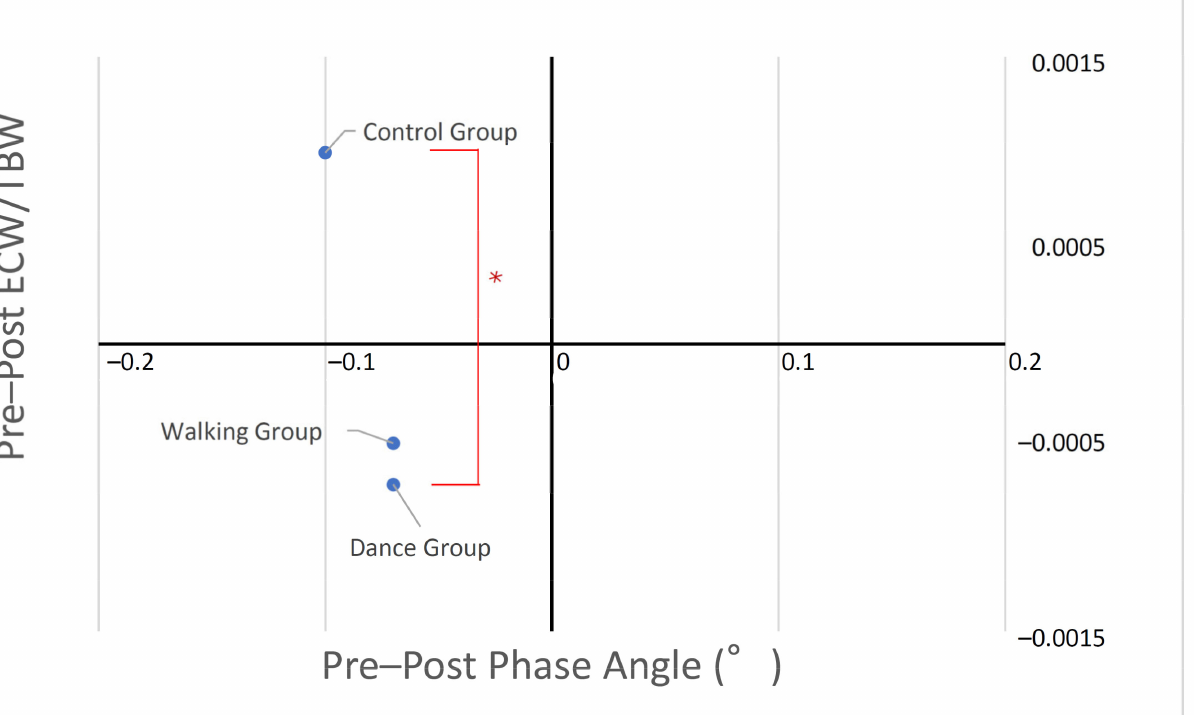
Figure 3. Comparison of the muscle quality by phase angle and extracellular water/total body water analysis based on the amount of change in the three groups. There was a significant difference between the dance and control groups in ECW/TBW at the red line. * p <